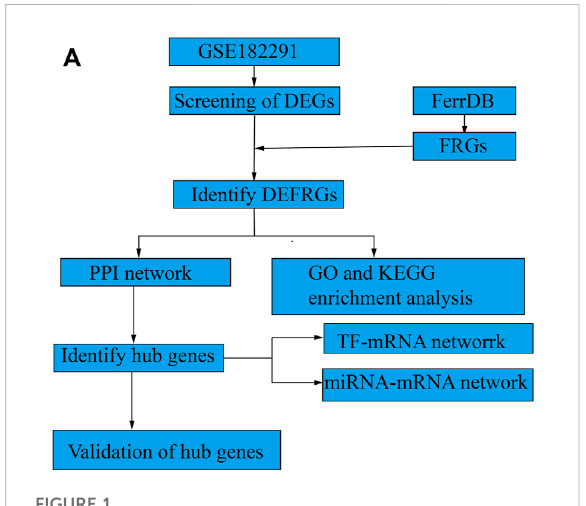
FIGURE 1 Study protocol. (A) The overall protocol of this